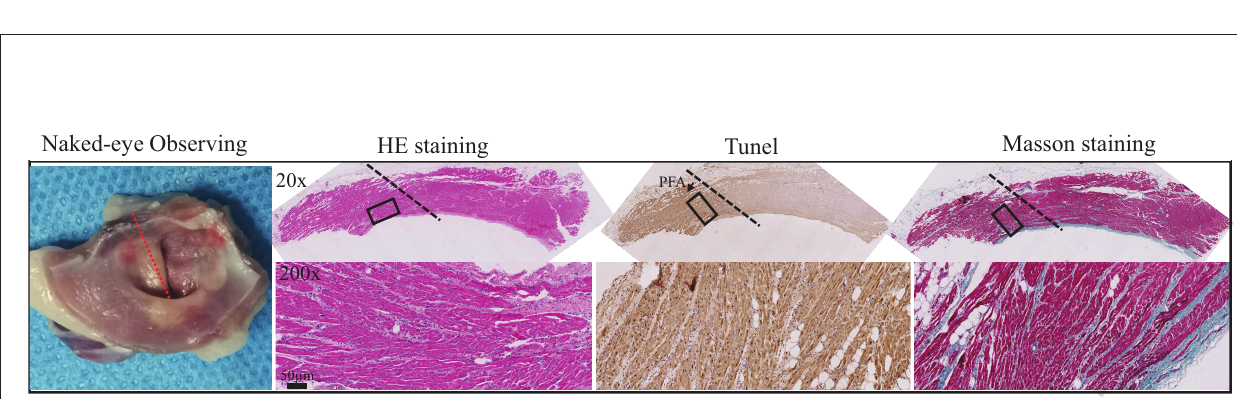
FIGURE 6 | Pathological changes of myocardial tissues after PFA ablation by Gross observation, HE staining, Tunel staining and Masson staining from left to right. Black dotted lines represent the ablation boundary; the images in the black box are shown in the bottom row at 10 times magnification. injury of smooth muscle cells is < 50% ( Figure 1B ), which fully not only was more sensitive to PFA than A7r5 but also has a demonstrates the high selectivity of PFA for completely different cell morphology. Both cardiomyocytes and